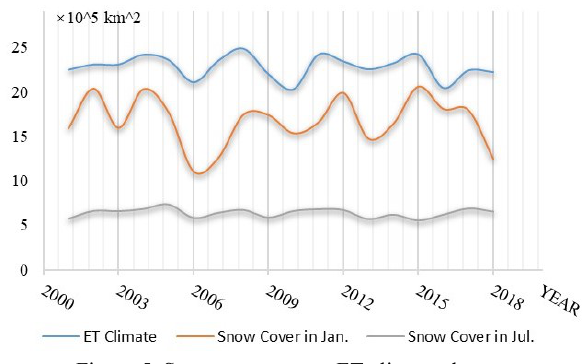
Figure 5. Snow responses to ET climate